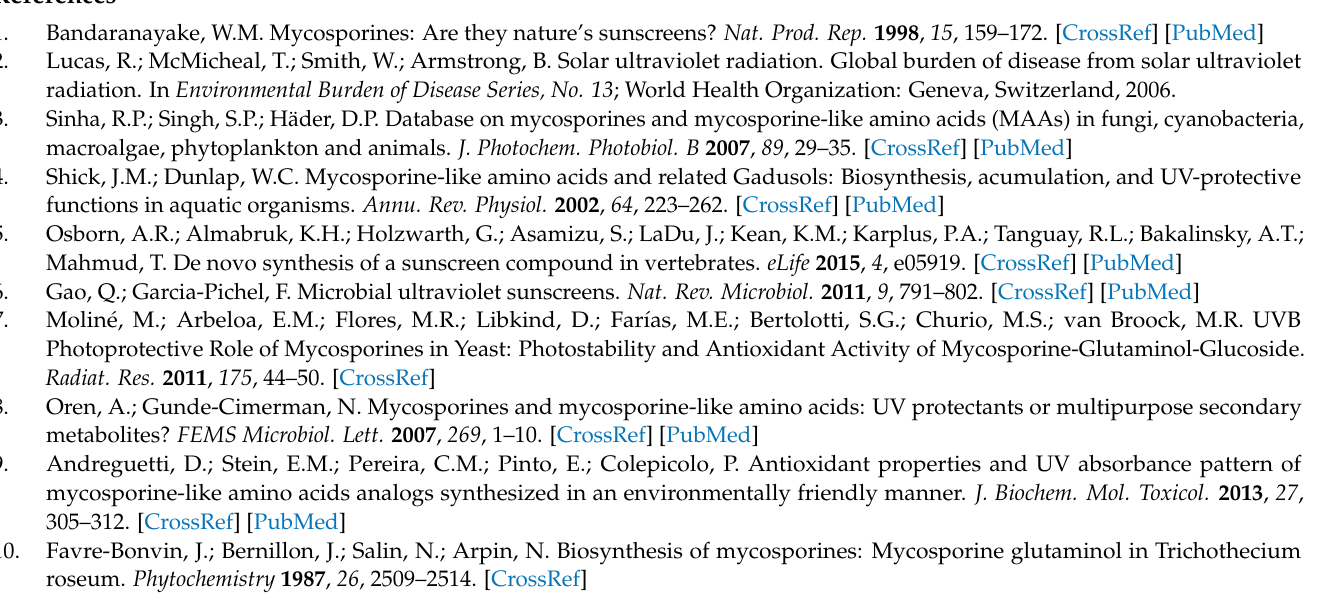
associated difference spectra and fitting residuals; Figure S6: Instrument response function; Figure S7: Solvent-only long time TAS; Figure S8: Power dependency studies; Figure S9: Spectrum output by the solar simulator; Figure S10: UV-visible and fluorescence spectra of usujirene/palythene and 9,10-diphenylanthracene [72,73]; Figure S11: Predicted UV-visible spectra for usujirene and palythene overlaying experimental spectrum; Figure S12: Active space orbitals for usujirene [20,22,55]; Figure S13: Active space orbitals for palythene; Figure S14: UV chromatograms at 360 nm for P. palmata extracts; Table S1: K-matrix used for global target analysis fit [35–37,74]; Table S2: S 0 geometries around the C1-C2-C3-N1 dihedral angle; Table S3: Calculated singlet vertical excitation energies for usujirene and palythene; Table S4: Calculated triplet vertical excitation energies for usujirene and palythene; Table S5: Optimised S 0 and S 1 /S 0 CI geometries for